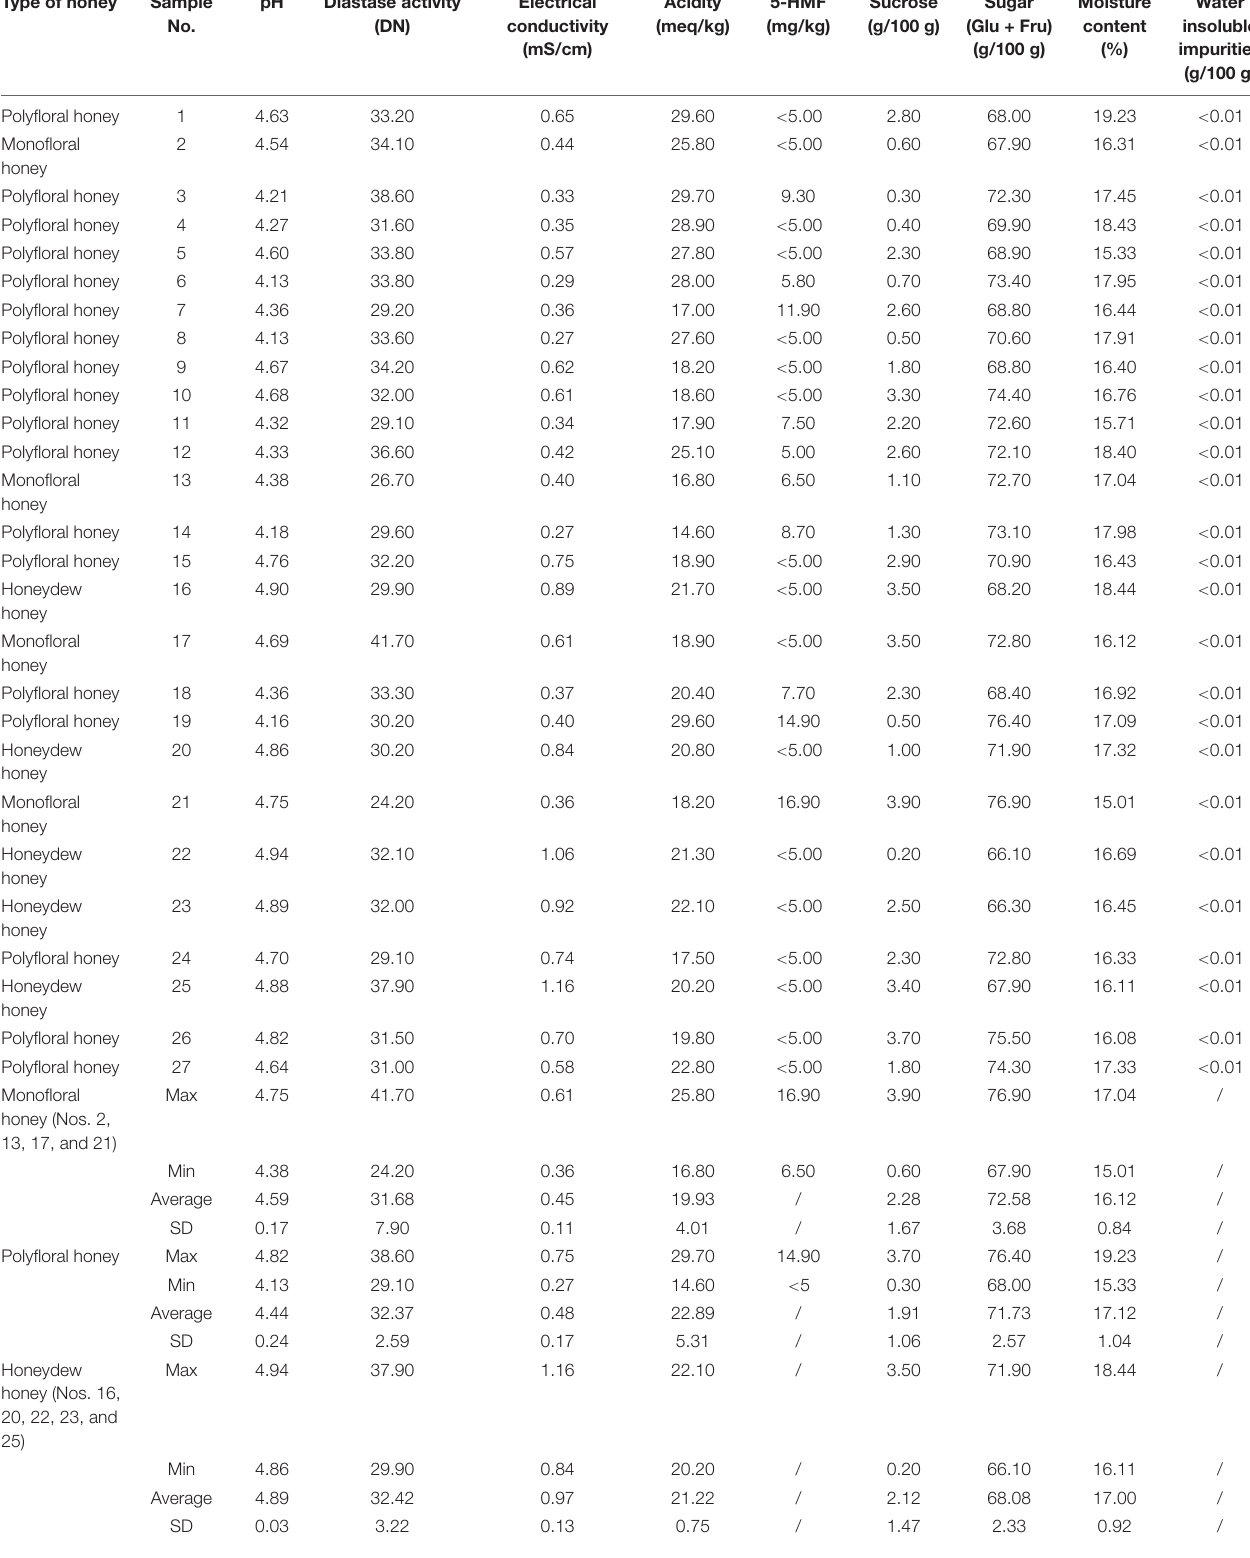
TABLE 3 | Physicochemical parameters with the descriptive analysis of analyzed honey samples from the Tara Mountain region in Serbia. Type of honey Sample